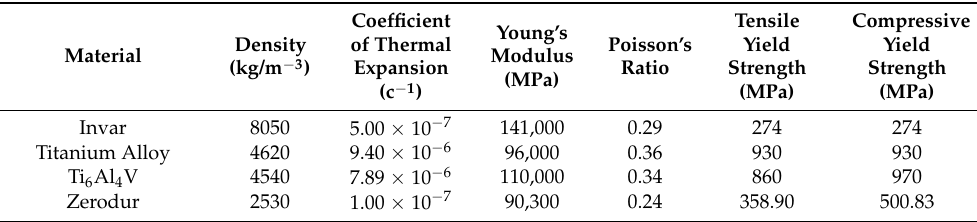
Table 2. Properties of different